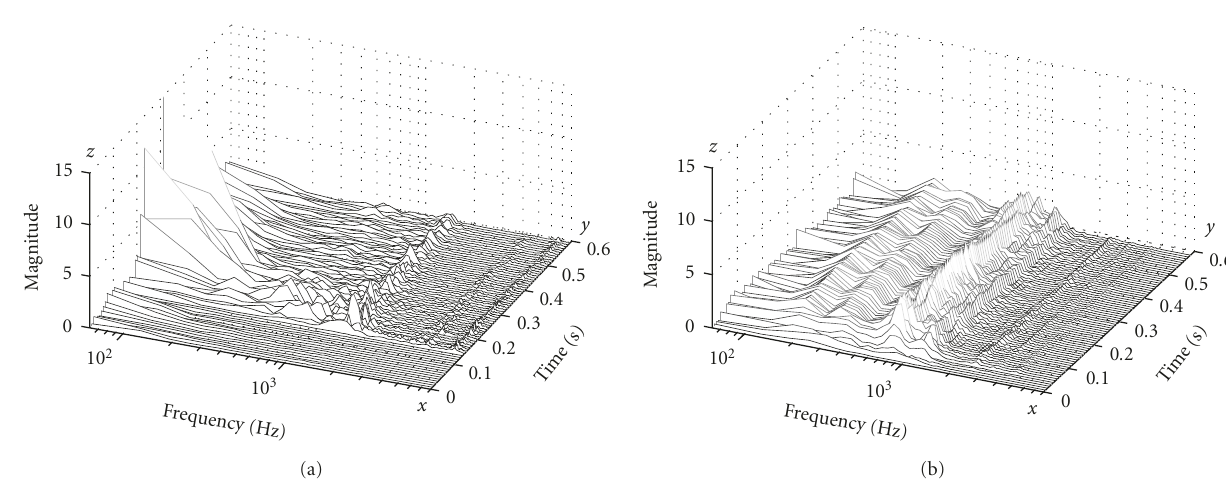
Figure 3: (a) FFT analysis of the first 600 ms of “ka”; (b) FFT analysis of the second 600ms of “ka.”